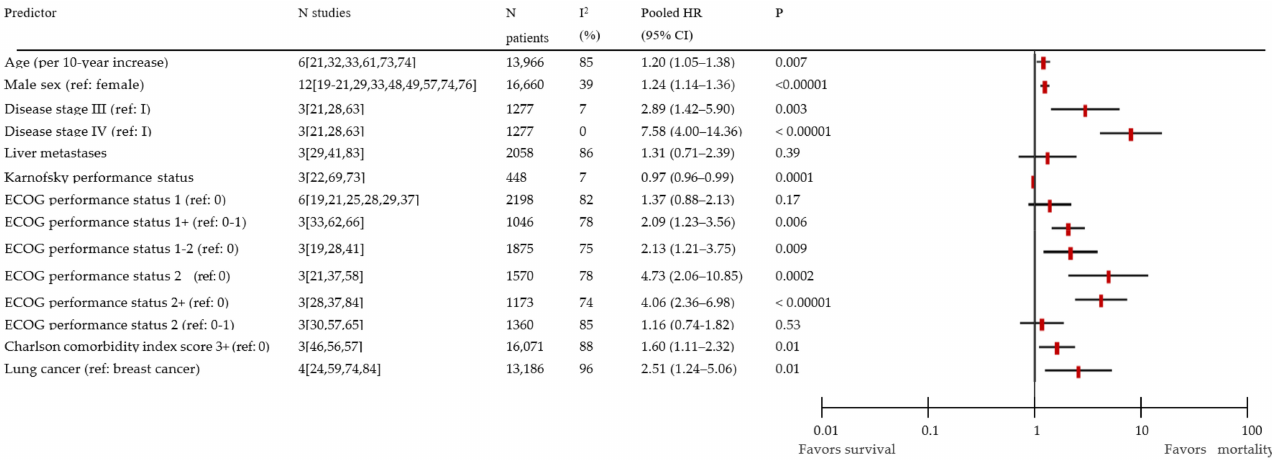
Figure 3. Forest plot of pooled hazard ratios for mortality with a random-effects model. CI: confidence interval; HR: hazard ratio; ECOG: Eastern Cooperative Oncology